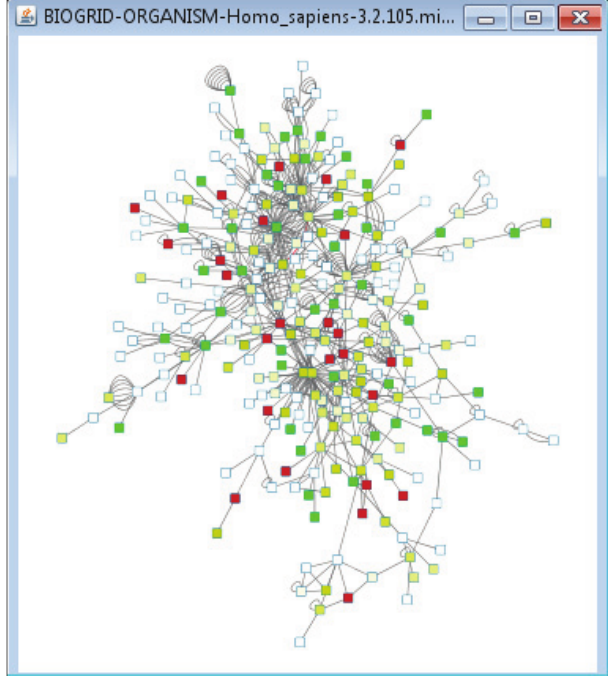
Figure 3. Template H. sapiens after gene expression